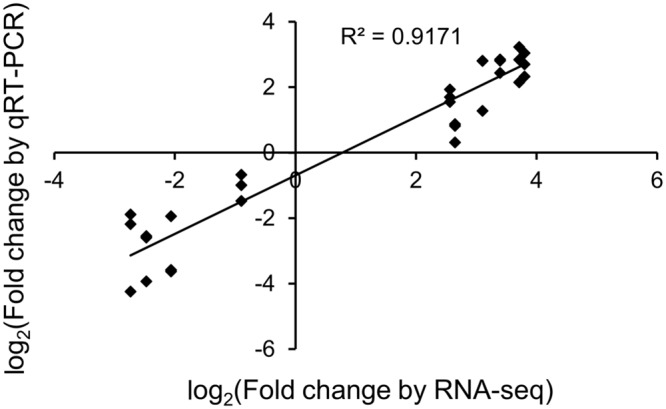
Validation of RNA-seq differential expression results. The correlation of JA-induced expression changes obtained from RNA-seq and qRT-PCR is shown for 10 transcripts, eight of which were randomly selected. Results for qRT-PCR are from three independent biological replicates for each transcript.